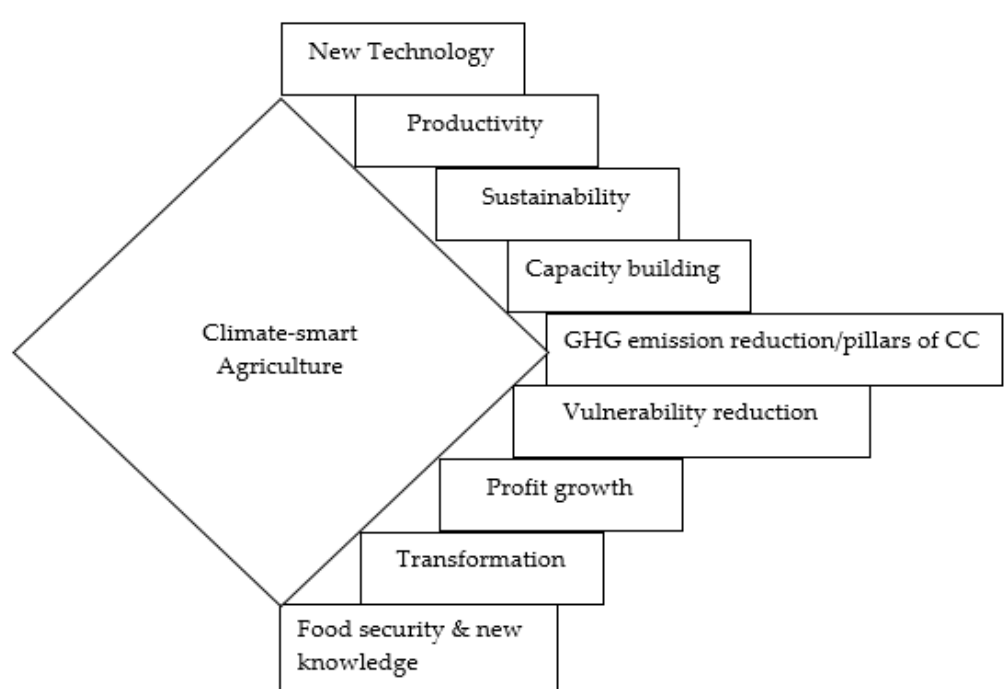
Figure 1. Key aspects of climate-smart agriculture (CSA).